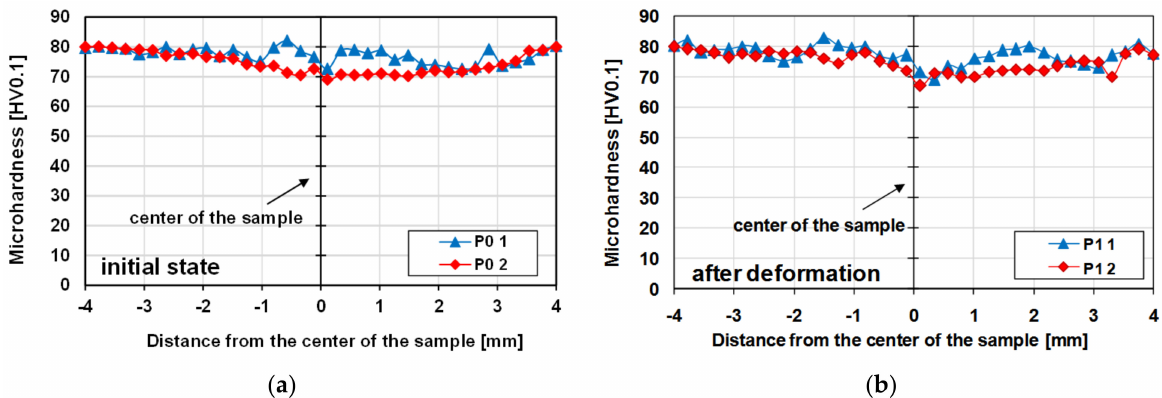
Figure 22. Changes in microhardness on the cross-section of the 5019 aluminium alloy samples (measurements made in two perpendicular directions—according to Figure 14): ( a ) undeformed material; ( b ) material after plastic